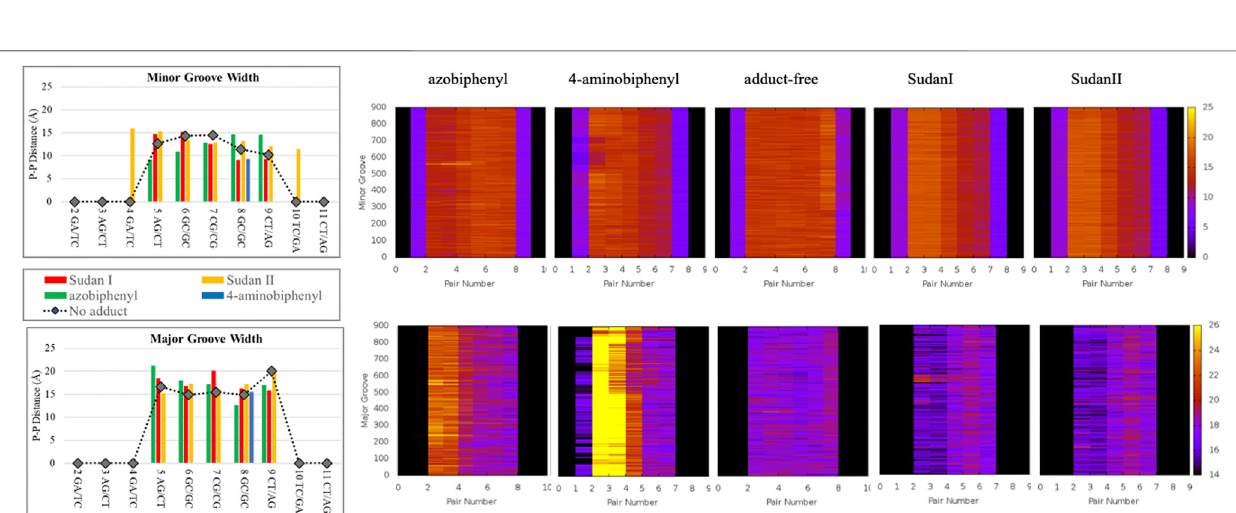
FIGURE 5 | The P-P distances (in Å) of minor groove (top) and major groove (bottom) after 100 ns of MD simulations. The unaltered DNA dodecamer (black lines) and adducts with Sudan I (red), Sudan II (orange), azobiphenyl (green), and 4-aminobiphenyl (blue). Note that for the 4-aminobiphenyl adduct, only the 7GC/GC pair is quanti fi edduetothedisruptionoftheB-DNAhelixbetweenotherbasepairs.Theheatmapsillustratethechangesinminorandmajorgroovesoverthe1 µstrajectory.In the heat maps, the z-axis (or the scale on theright) representsthe P-P distance in Å,and the y-axis (on the left) representsthe time in ns (starting from 100 ns). The base pair numbers are across the